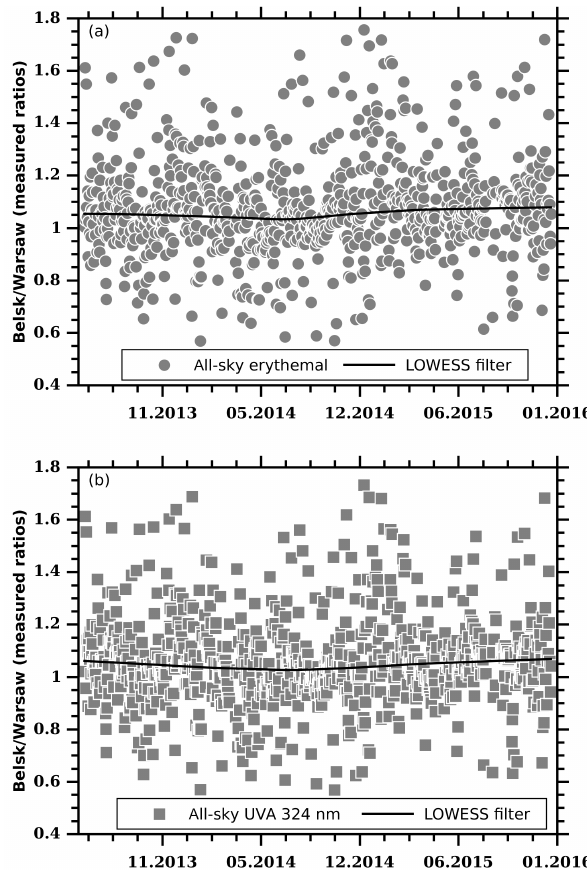
Figure 4. Same as Fig. 3 but for the near-noon partial daily dose (noon − 3h, noon + 3h) for all-sky conditions. Solid curves repre- sent the data smoothed by the LOWESS